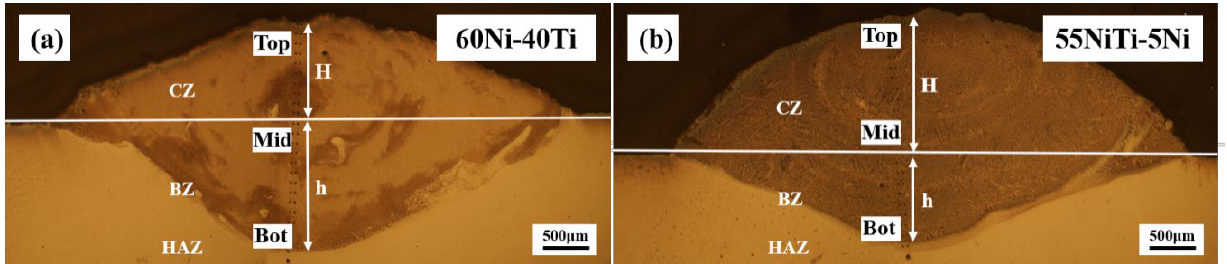
Figure 2. XRD patterns of coatings.